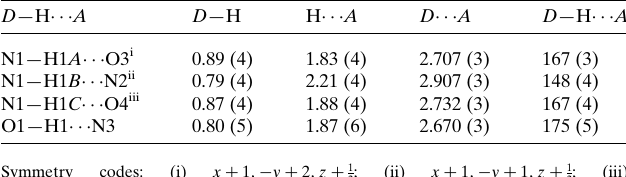
Table 1 Hydrogen-bond geometry (A˚ , (cid:5) ) for Ia .